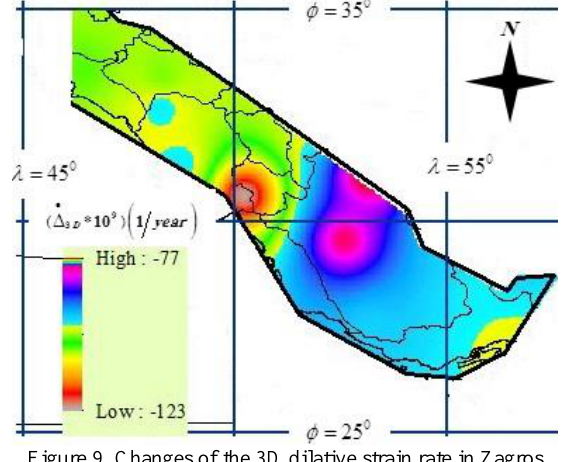
Figure 9. Changes of the 3D dilative strain rate in Zagros